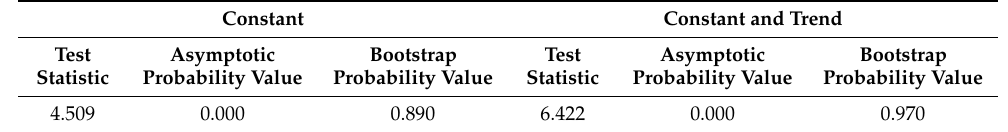
Table 6. Panel cointegration